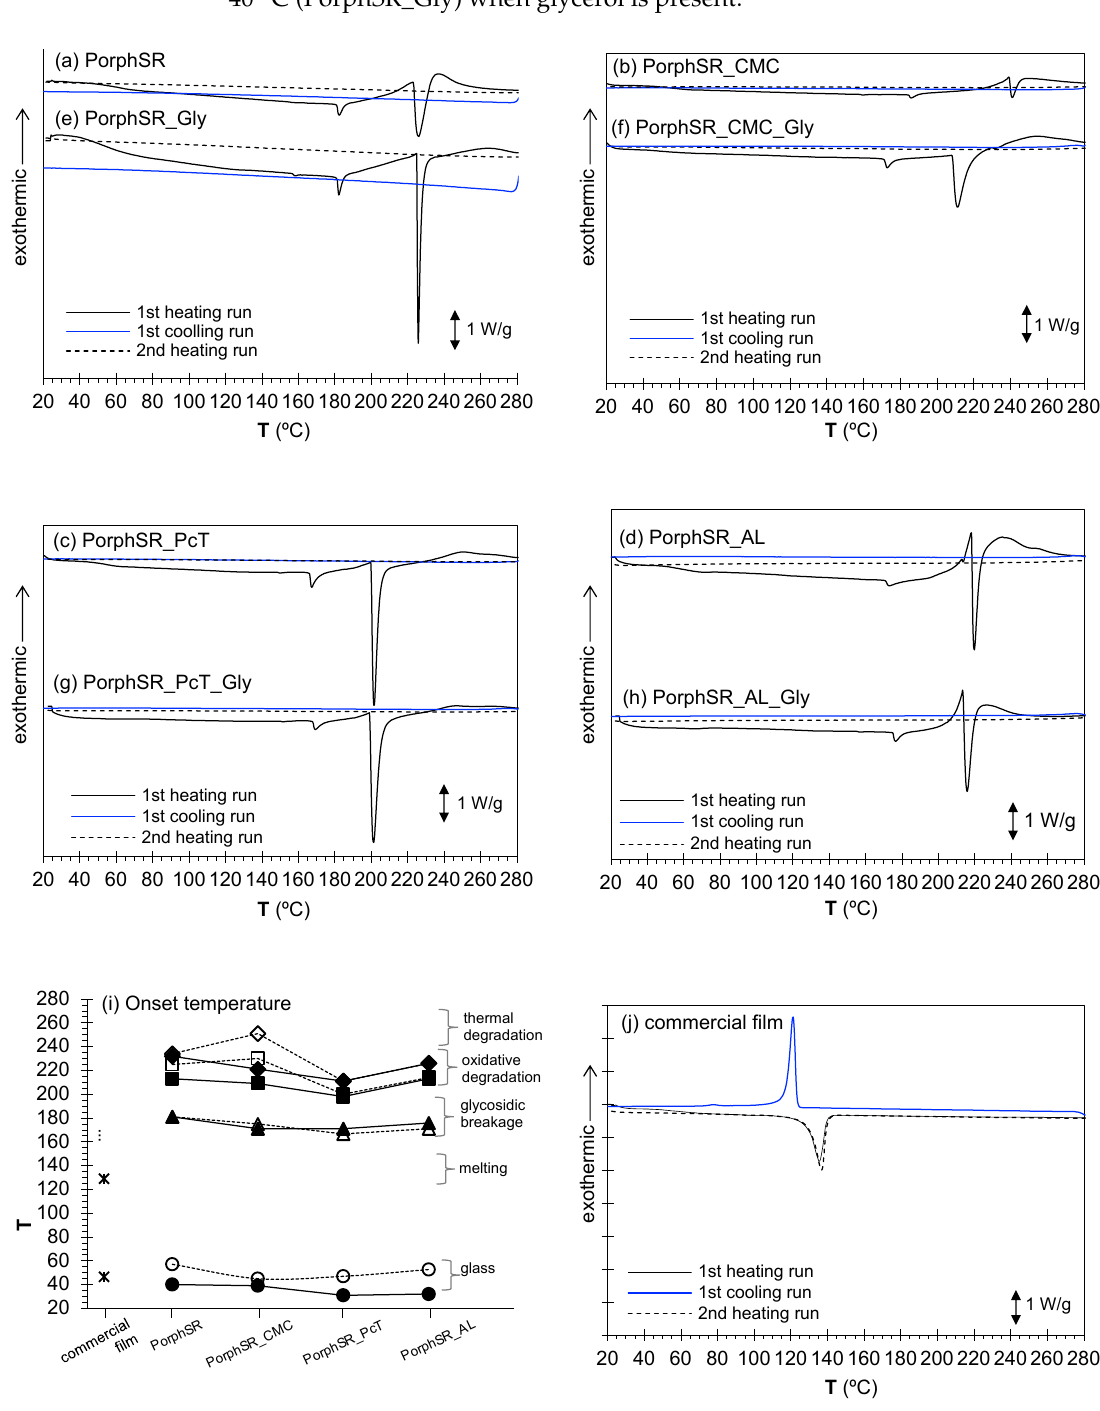
transition onset (Figure 7i) ranged from approximately 45 ◦ C (PorphSR_CMC) to 57 ◦ C (PorphSR) in films without glycerol and from approximately 31 ◦ C (PorphSR_PcT_Gly) to 40 ◦ C (PorphSR_Gly) when glycerol is present.